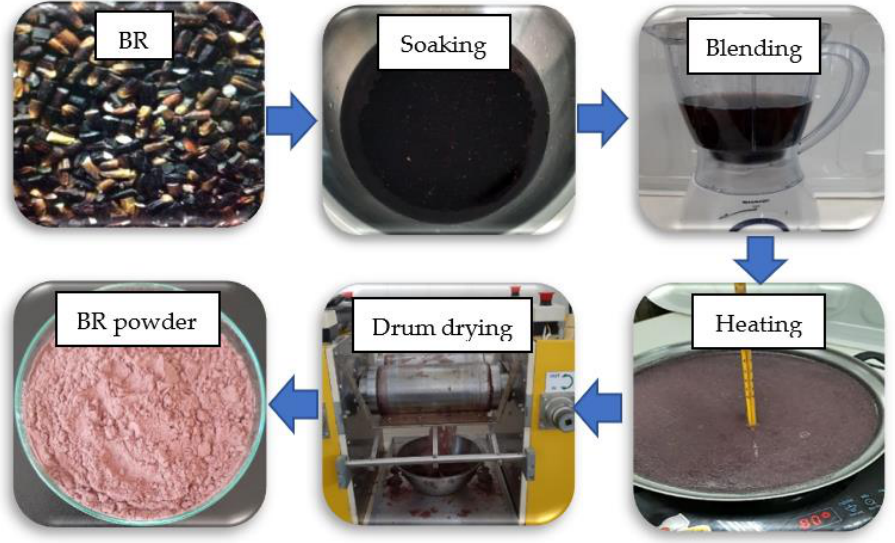
Figure 1. The process of preparing BR powder and its